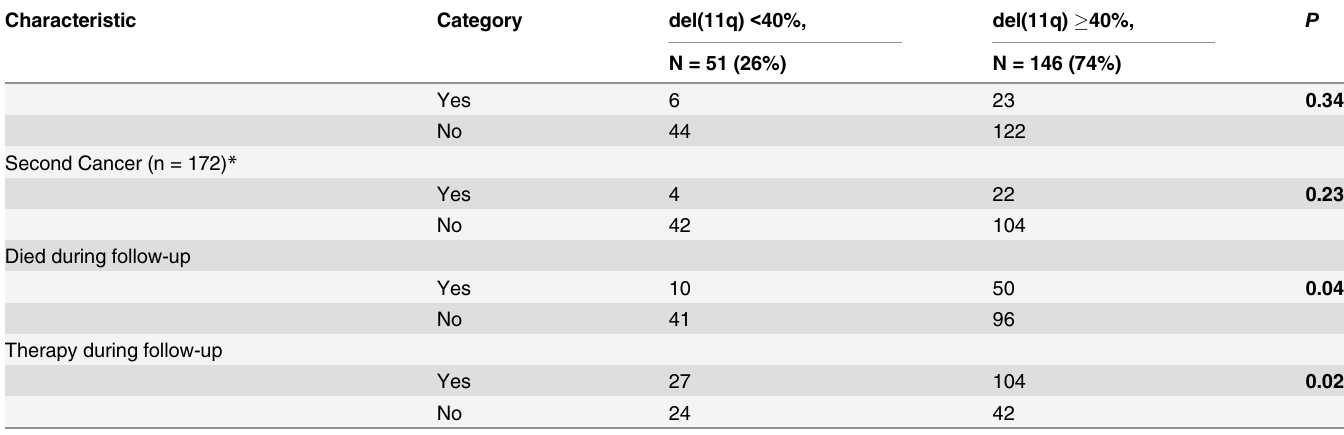
M ( P < 0.0001), 2 M 2